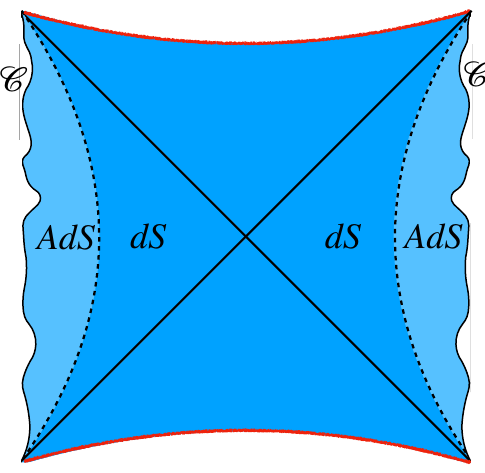
Figure 1 . Penrose diagram for the interpolating solution. The dashed lines interpolate between a negative and a positive curvature region, that are coloured in light and darker blue, respectively. C is the boundary curve close to the AdS boundaries. Inside the horizons, the geometry is locally dS 2 , but depending on whether (cid:20) is positive or negative, the dilaton behaves as in the interior of a dS black hole or as in the dS cosmological